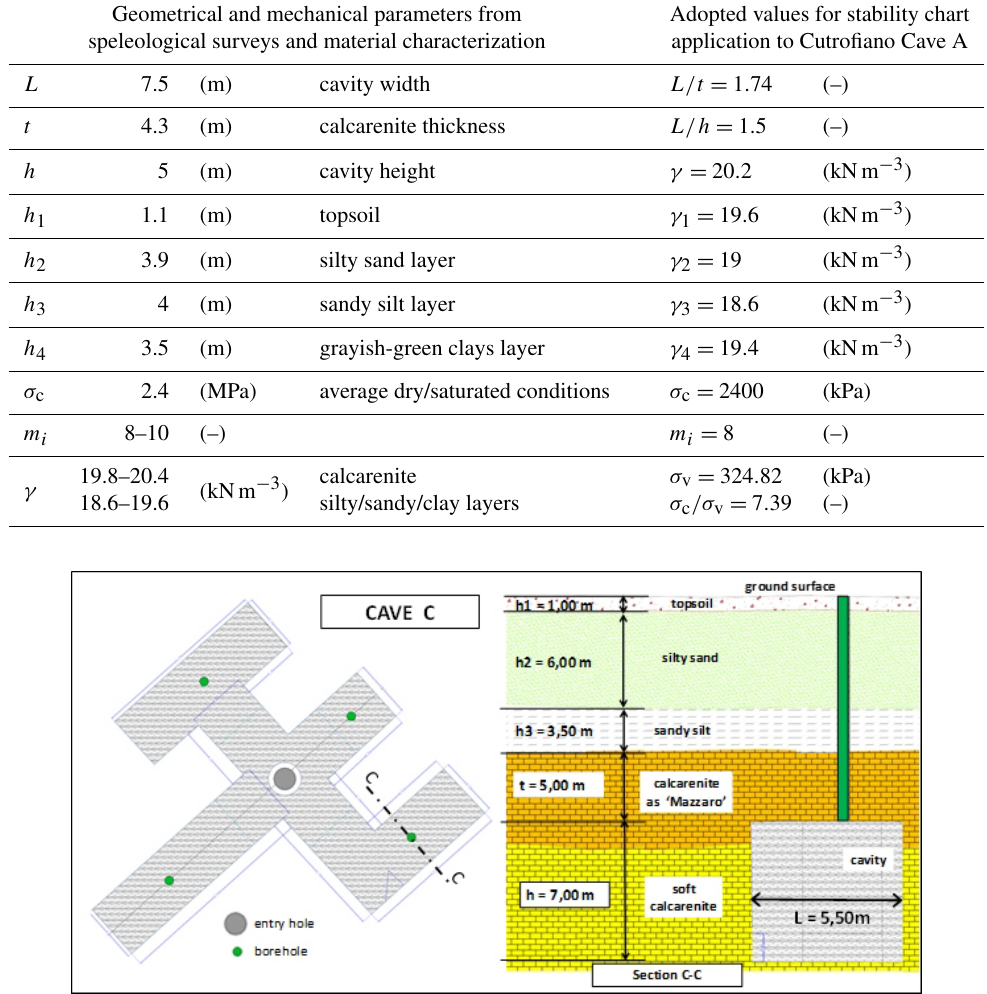
Figure 22. Plan and stratigraphy of the underground cavity C (adapted from Maglio and Ligori,